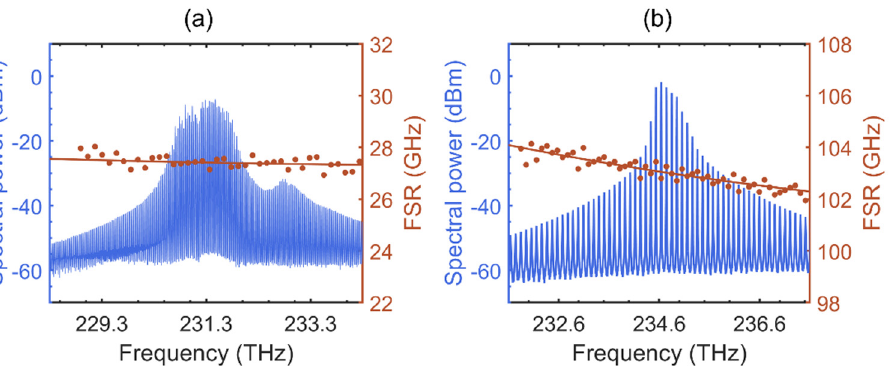
Figure 8. Optical spectrum (blue) and corresponding free spectral range (FSR) as a function of the longitudinal mode frequency (red) for ( a ) QD and ( b ) QW laser. The red solid lines are guiding lines for the FSR variation. Both devices operate at twice the threshold current.